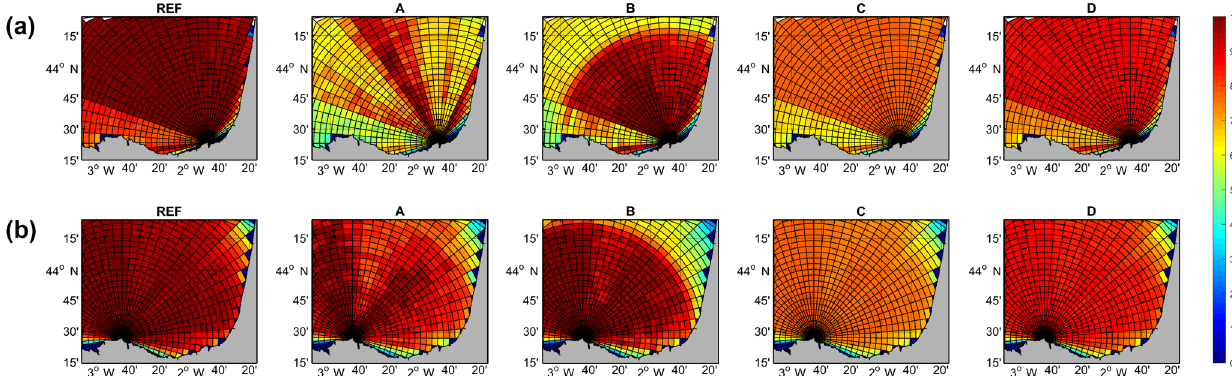
Figure 4. Maps of temporal coverage (percent of the total number of hours in the 3-month period analyzed) for Higer (a) and Matxitxako (b) for the REF series and all the experiments.